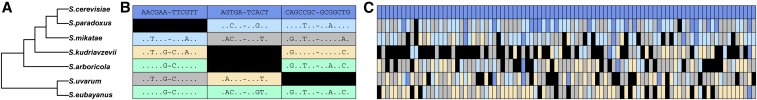
Evidence for quasi-palindrome to palindrome conversion via template switching during evolution of S. cerevisiae. (A) A phylogenetic tree of seven Saccharomyces genomes. (B) Three perfect palindromes appear in S288c three coding regions. Different perfect palindromes appear at the same loci in three additional genomes. Each locus is shown in a column and different colors show different palindrome forms. Loci that are in a quasi-palindromic state are shown in gray. Cases in which the loci could not be identified are shown in black. Positions identical to S288c are shown with a dot and the spacer between arms is represented with a tilde sign. (C) Ninety-two S288c loci that appear in two additional genomes.